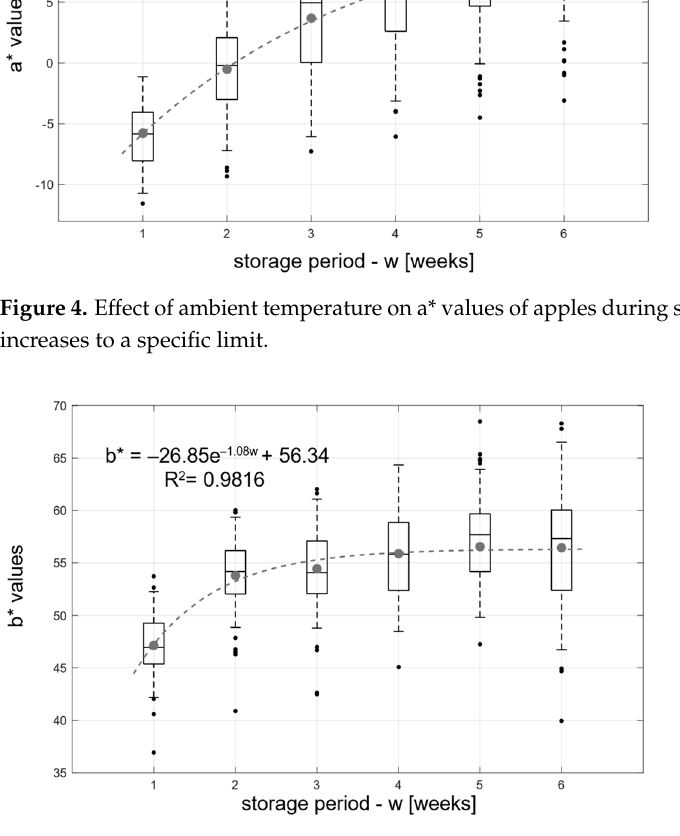
Figure 5. Effect of ambient temperature on b* color values of apple during storage: the yellow color parameter increases to a specific limit.